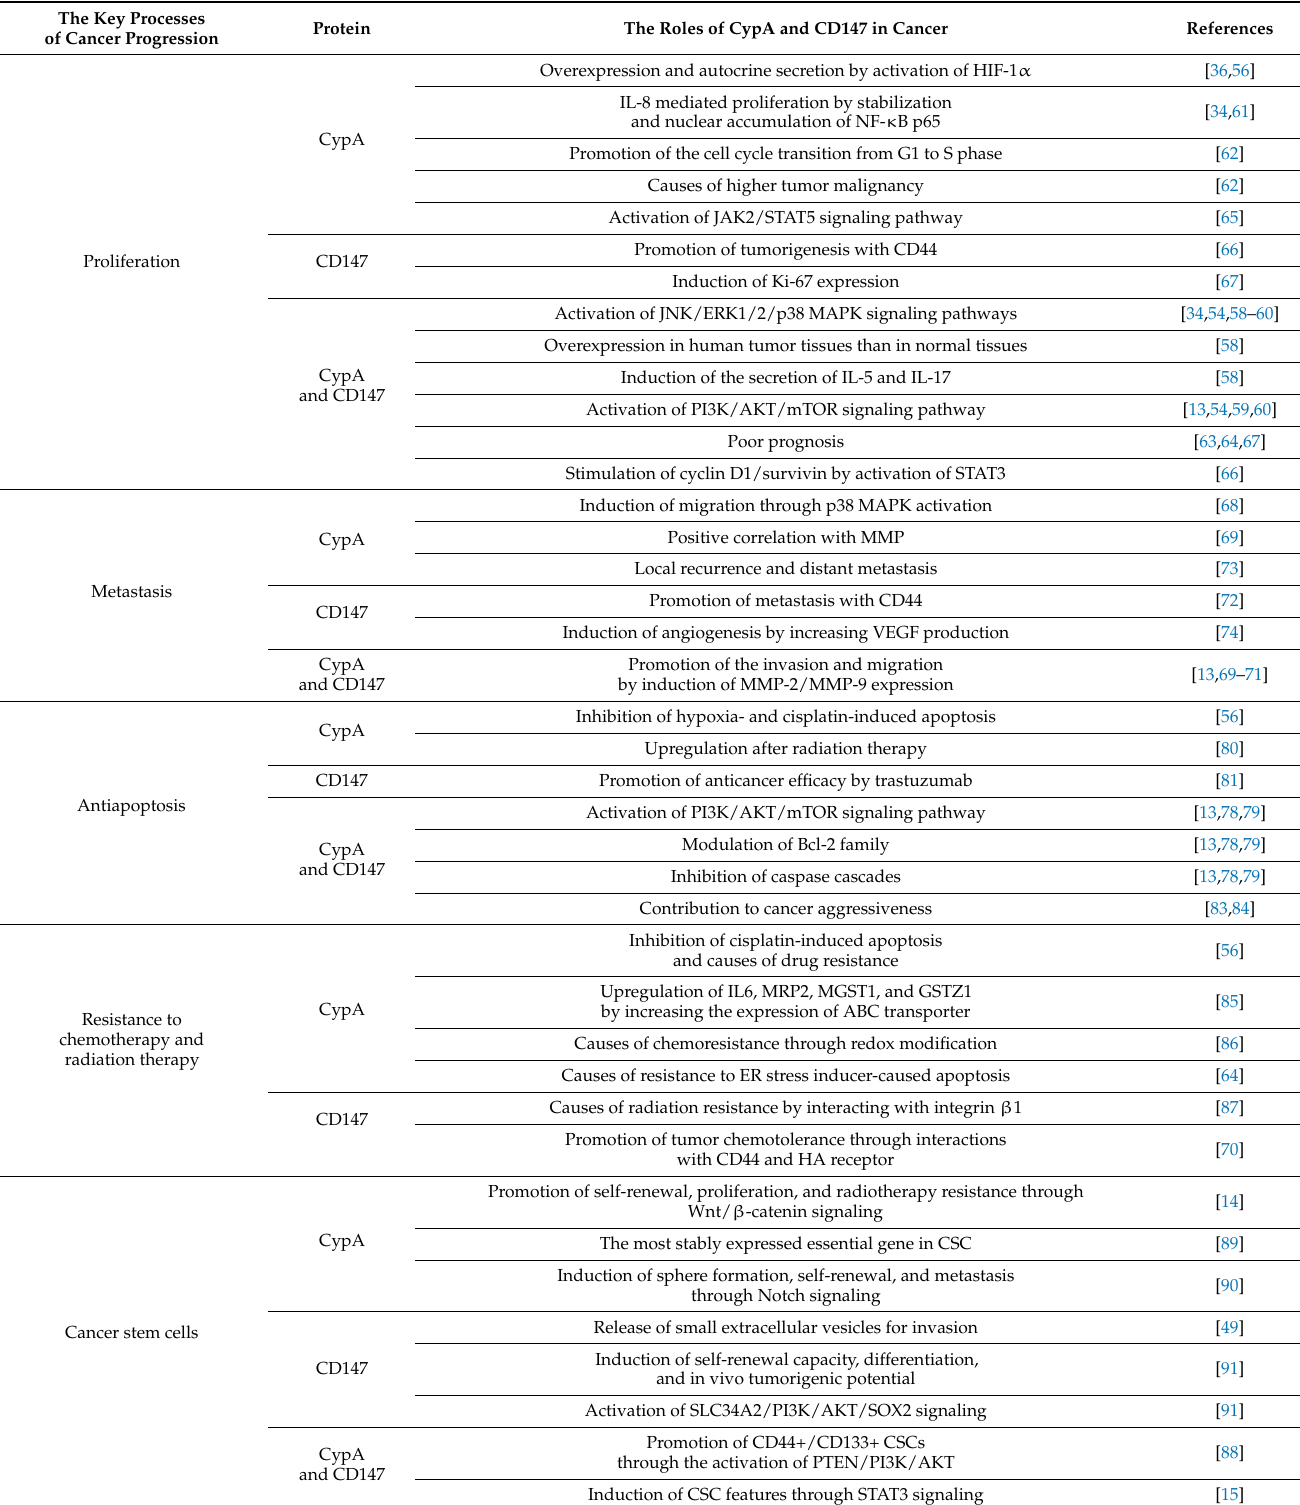
Table 1. The roles of CypA/CD147 in